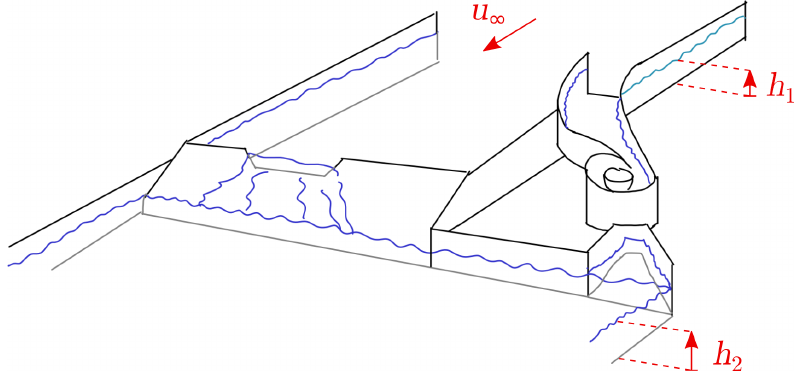
Figure 2. Drawing of the WVPP in the type of installation it has been designed for: as the bypass to the main flow of a river. The heights h 1 and h 2 , formally described in ref. [25], remain unaffected by its